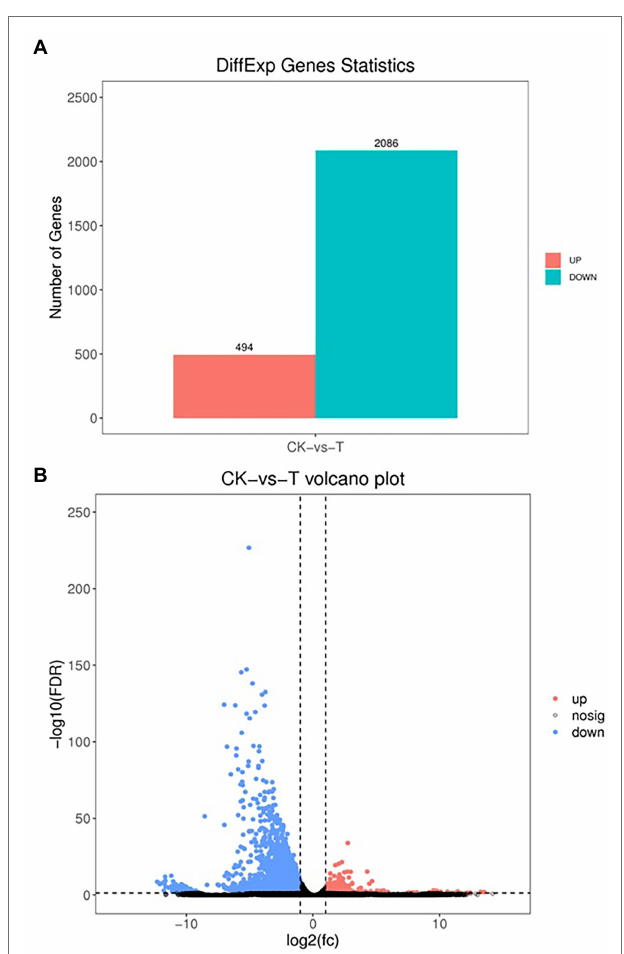
FIGURE 7 | Differential expression analysis of RNA-seq (A) , the volcano indicates the differentially expressed genes (DEGs; B ). Each dot in the figure signifies a particular DEG. The red dot shows upregulated DEGs. The blue dot indicates downregulated DEGs, and the dark grey dot is a non-significant differential